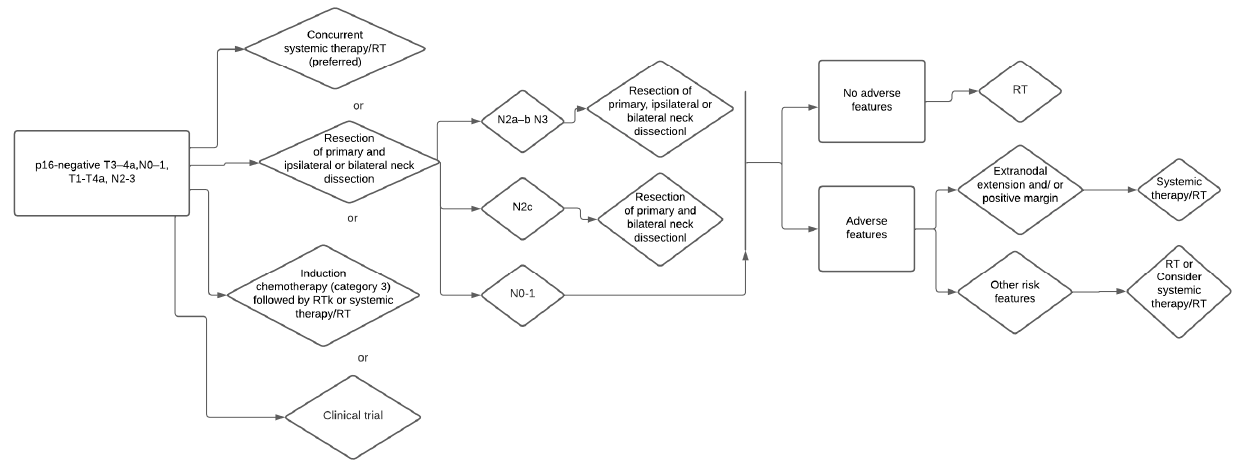
Figure 2. AJCC Decisional tree p-16 negative, T3-T4a N0-1 or T1-4 N2-3.